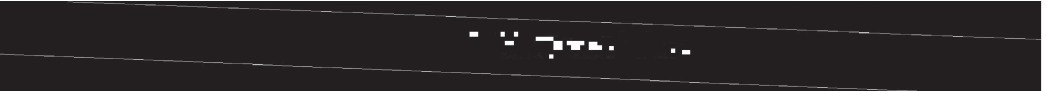
Figure 9: Refining detections by the elimination of false blocs corresponding to the reflections and the movement of the lines delimiting the lanes. Swimming Championships in Limoges, France, April 2015.